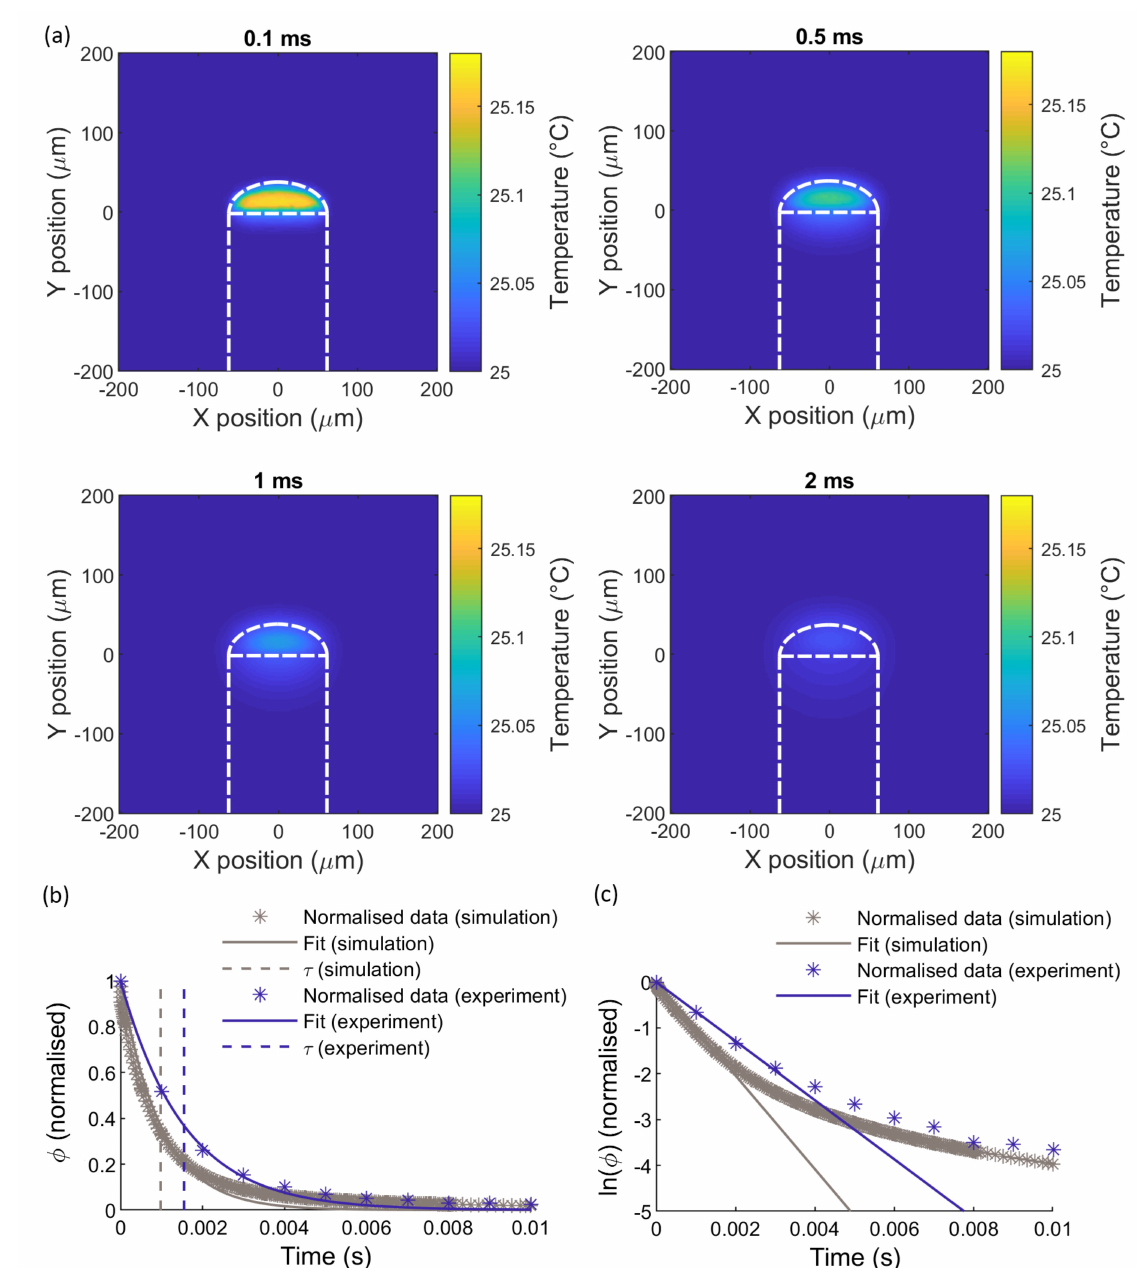
Figure 5. Laser-heated dome sensor simulation results: ( a ): temperature distribution in the x-y plane at different time points; ( b ) expected sensor signal calculated using the simulated temperature distributions, compared with experimental data. Both simulated and experimental data were normalised by subtracting the baseline and dividing by φ ( t = 0 ) . The solid lines are fitted impulse response curves of the form of Equation (9), and the dashed lines indicate the time constants obtained from the fitted coefficient τ . Only data for t ≤ 0.01 s are shown, to show the differences in the two curves more clearly. ( c ) Natural logarithm of the data and fitted curves versus time for simulation and